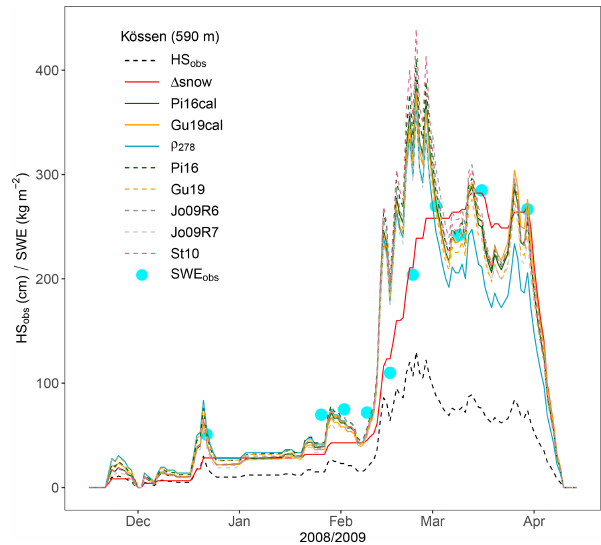
Figure 4. SWE simulations and observations (SWE obs ) for the win- ter 2008/09 in Kössen (cf. Fig. 3). Details and abbreviations are given in the text (Sect. 3.2) and summarized in Fig.